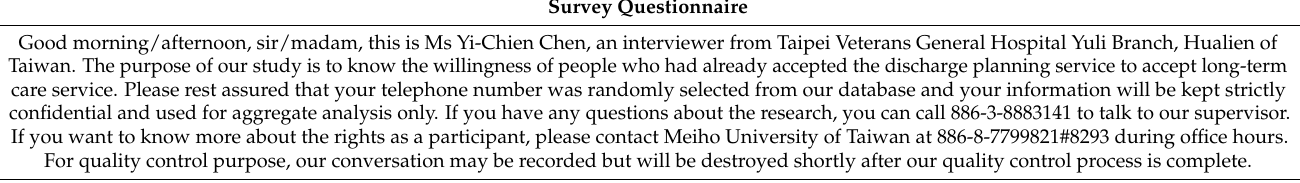
Table A1. Survey